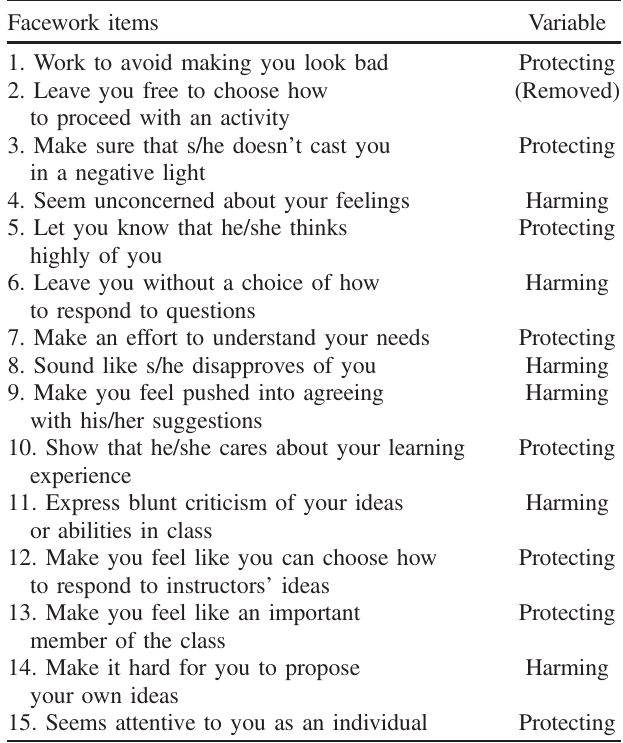
TABLE IV. Items in the facework instrument, on the week 14 survey. Students responded to the prompt, “ Think about the direct interactions you had with the lead instructor in your physics class (e.g., during individual or whole-class discussions). With those in mind, please respond to all of the questions below (even if some seem redundant) indicating the degree to which each describes your interactions. ” Responses ranged from 0 (not at all) to 6 (very much). Each item is identified as relating to either “ protecting ” or “ harming ”